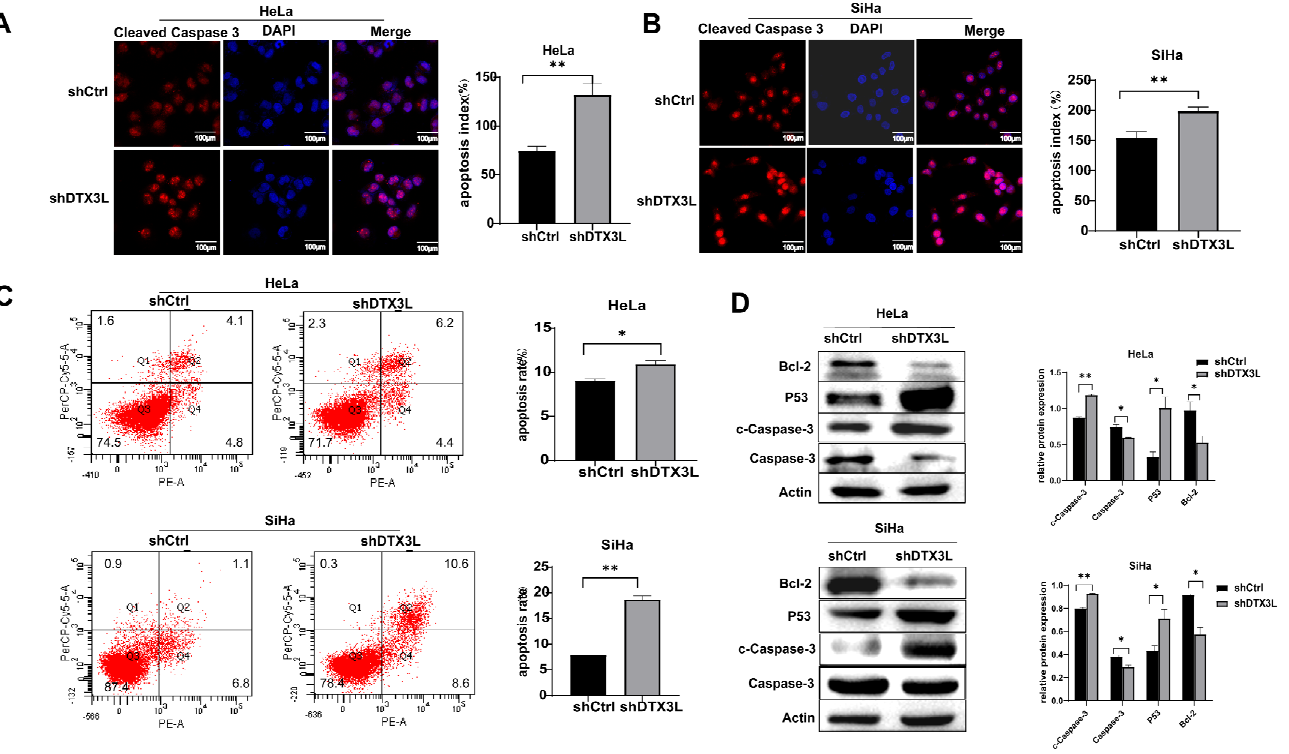
Figure 5. Knockdown of DTX3L promoted HeLa and SiHa cell apoptosis. ( A , B ) Immunofluorescence analysis of c-Caspase-3 expression in HeLa and SiHa cells treated with shDTX3L or shCtrl. The quantified result is shown in the right pane. ( C ) The apoptosis ability of HeLa and SiHa cells was detected by flow cytometry, and the percentage of early apoptotic (PE-A+/7-AAD − ) and late apoptotic (PE-A+/7-AAD − ) cells were combined for analysis. The quantified result is shown in the right panel. ( D ) Protein expression of Bcl-2, P53, Casepased-3 and c-Casepased-3 in HeLa and SiHa cells transfected with shDTX3L or shCtrl were determined by Western blot analysis. The bar chart in the right shows the ratio of Bcl-2, P53, Casepased-3 and c-Casepased-3 to Actin by densitometry. * p < 0.05; ** p < 0.01.